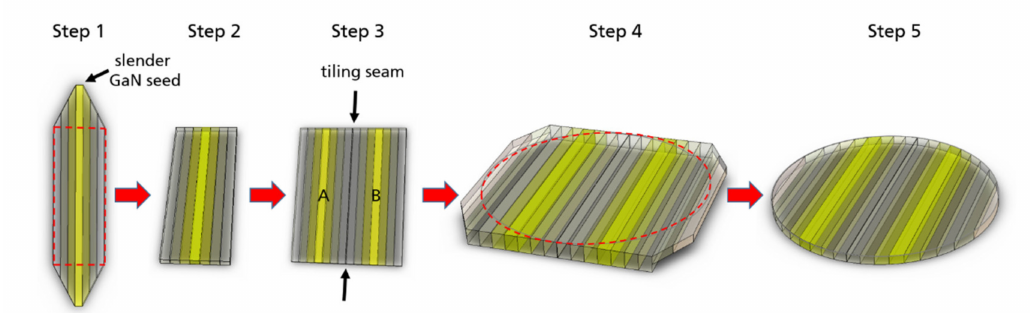
Figure 1. Scheme of the substrate manufacturing steps starting from slender GaN seeds to the finished wafer: Step 1, multi regrowth of a slender GaN seed in the lateral 〈 1120 〉 directions; three new-grown crystal areas crystallized in three separated processes are marked; Step 2, new crystal sliced from the overgrown seed of Step 1; Step 3, two cut out crystals are joined together by tiling technology; Step 4, GaN continues to grow in the lateral 〈 1120 〉 directions as well as in vertical [0001] direction in multi regrowth steps; Step 5, when the necessary size is reached the as-grown GaN crystals can be drilled, sliced and polished in a proper way to produce